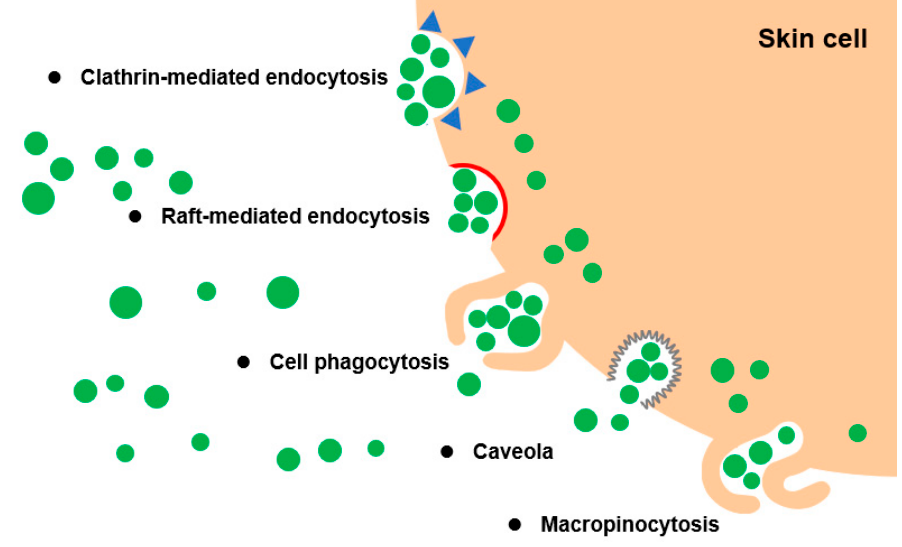
Figure 3. Cellular internalization of PELNVs by phagocytosis pathway.